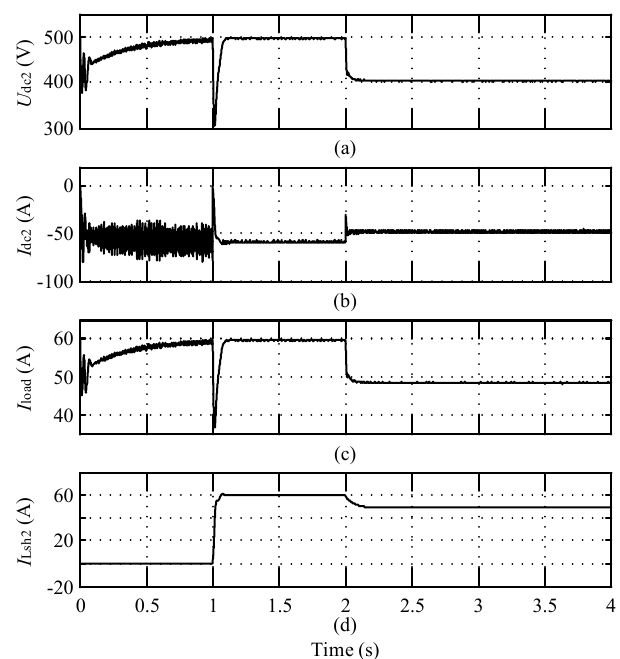
Figure 12. Simulation curve of boost converter side of small current bipolar short circuit. ( a ) Capacitor C b voltage U dc2 . ( b ) VSC-side cable current I dc2 . ( c ) Load resistance current I load . ( d ) Current over current-limiting inductor in FCL2 I Lsh2 .